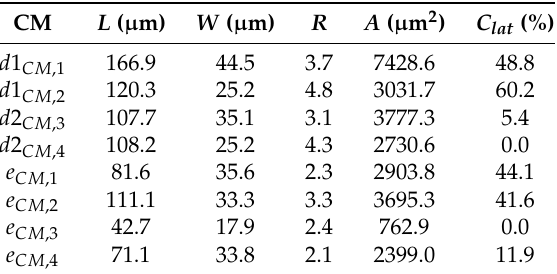
Table 3. Morphological measurements ( L , W , R and A ) and C lat values for automatically detected CMs in images d 1, d 2 and e under the supervised mode. d 1 CM , i , d 2 CM , i and e CM , i , i ∈ { 1, 2, 3, 4 } , denote the evaluated CMs in images d 1, d 2 and e , respectively, which are shown in Figures 14 and 16.